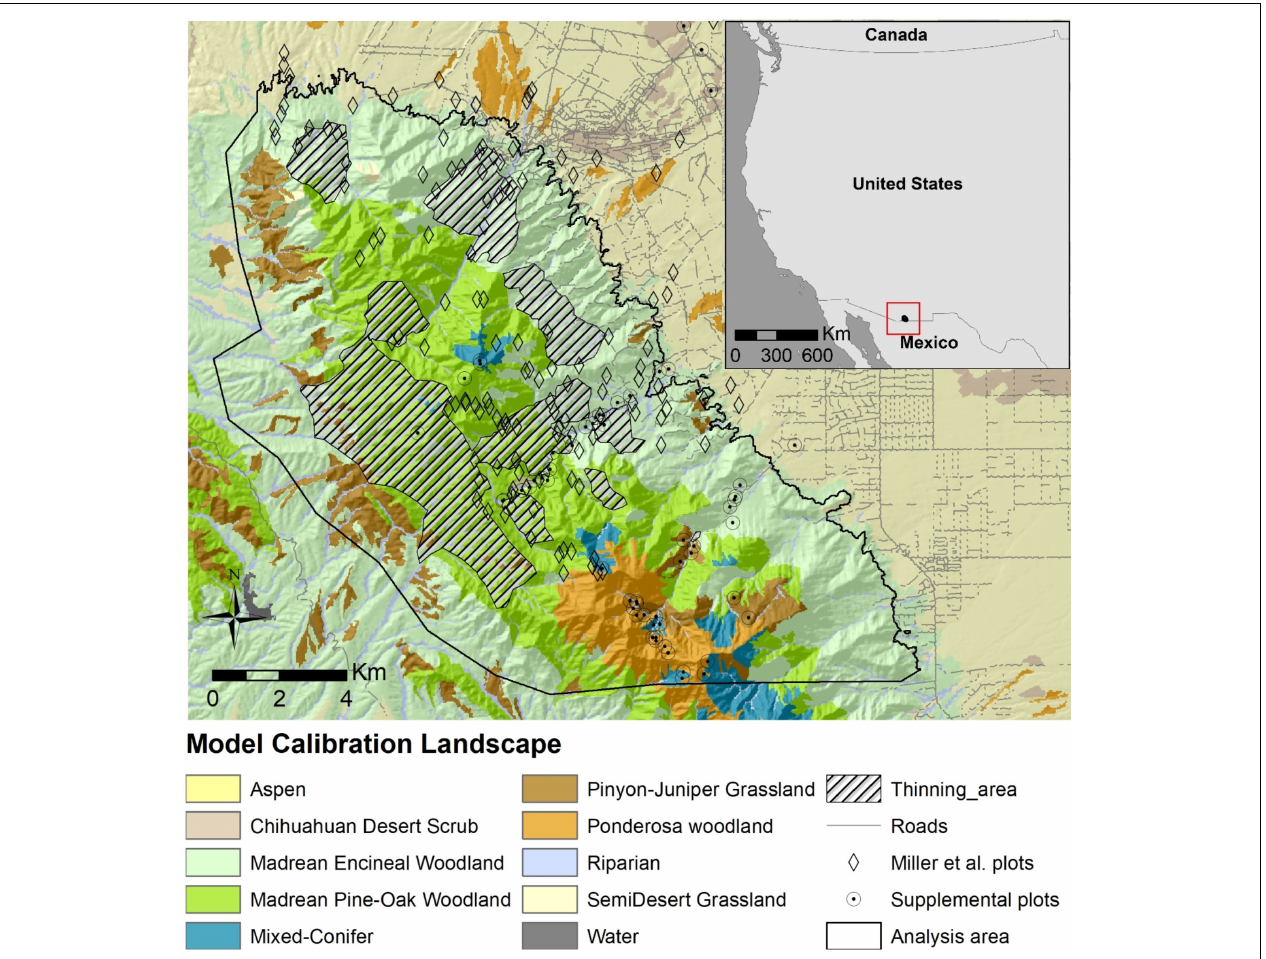
FIGURE 2 | Distribution of existing ecological response units and sampling plots for model calibration. Each of 10 ERUs received a different daily weather stream based on elevation and solar exposure. Individual tree counts and size distributions from sampled plots were used to develop the simulation landscape.